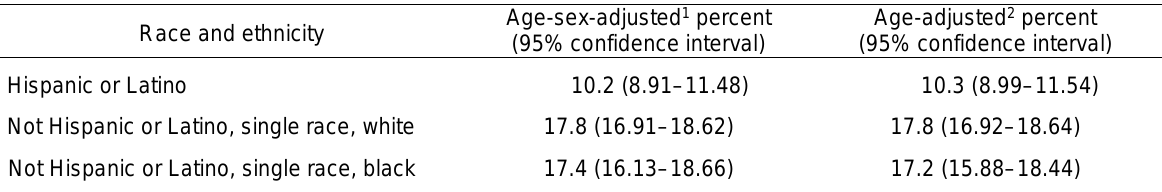
Data table for Figure 8.4. Age-sex-adjusted prevalence of current cigarette smoking among adults aged 18 and over, by race and ethnicity: United